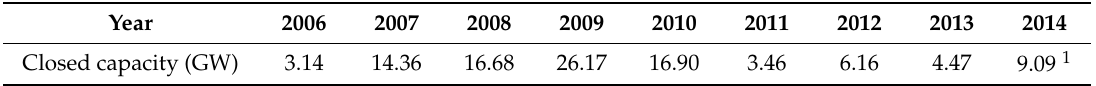
Table 1. Closure of small coal power generation during